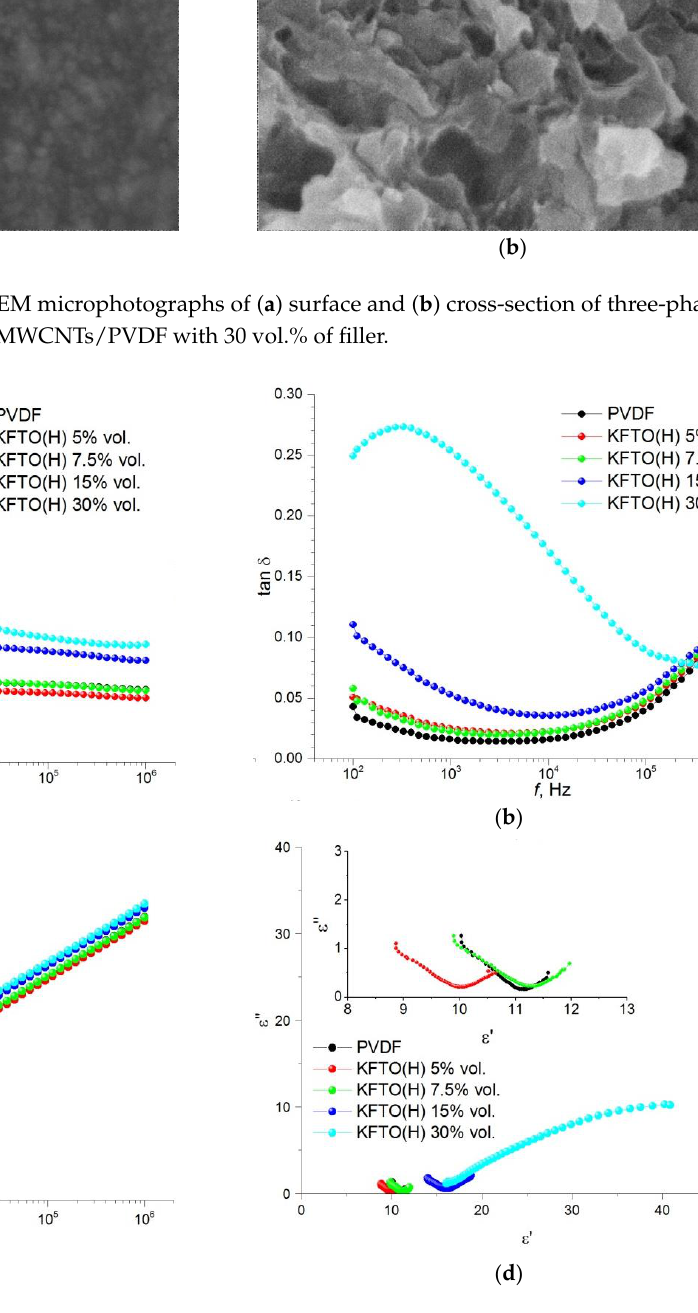
Figure 7. Frequency dependence of ( a ) permittivity, ( b ) dielectric loss tangent, ( c ) conductivity and ( d ) Cole –Cole plot (ε ′ –ε ″ ) for PVDF-based composites with different volume fractions of KFTO(H) (inset is the enlarged view of the basic figure).